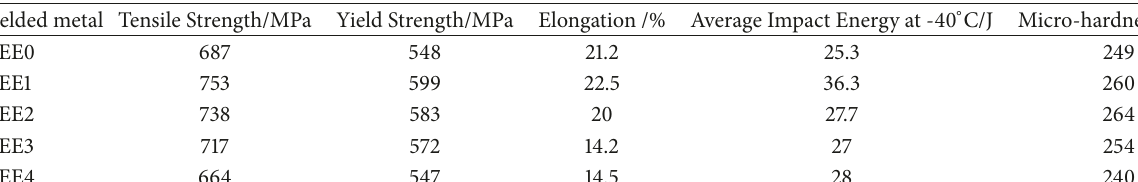
Table 7: Mechanical properties of the welded metals with different amounts of REE.